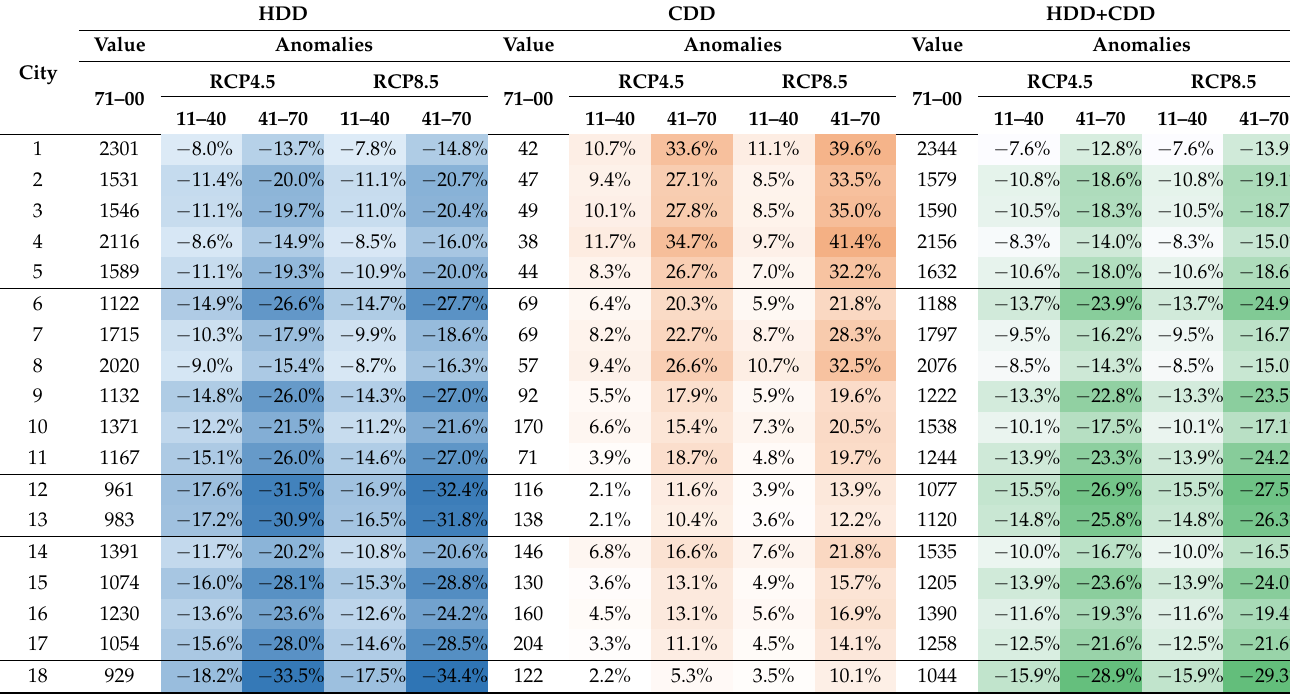
Table 5. Anomalies in ◦ C × D per year for HDD, CDD and HDD + CDD between 2011–2040 and 2041–2070 (under both RCPs) and 1971–2000 (historical period) for the city locations in NUTS II listed in Figure